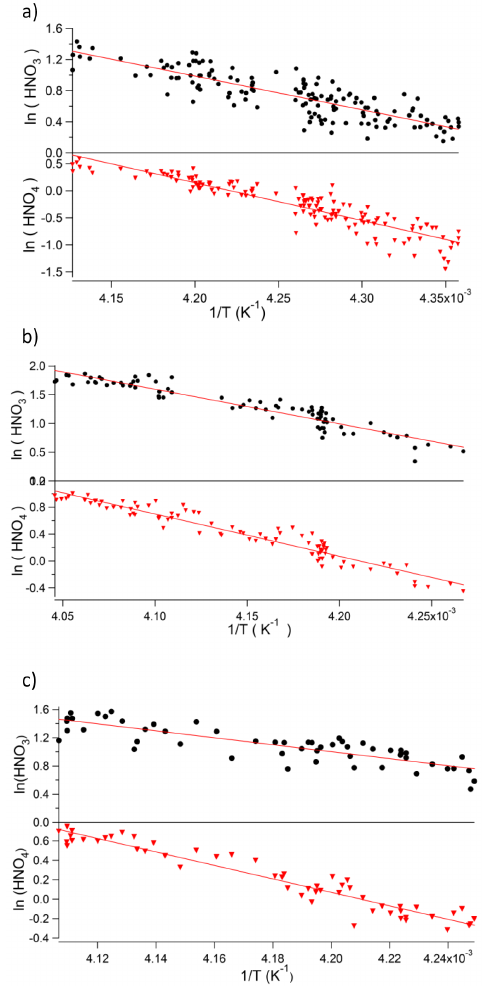
Figure 7. Plots of ln(HNO 3 ) and ln(HO 2 NO 2 ) vs. 1/T for the time periods shown in Fig. 6, i.e. (a) 30 May, (b) 21 June, and (c) 18